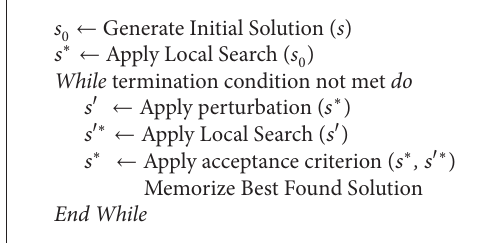
Algorithm 1: Iterated local search (ILS)